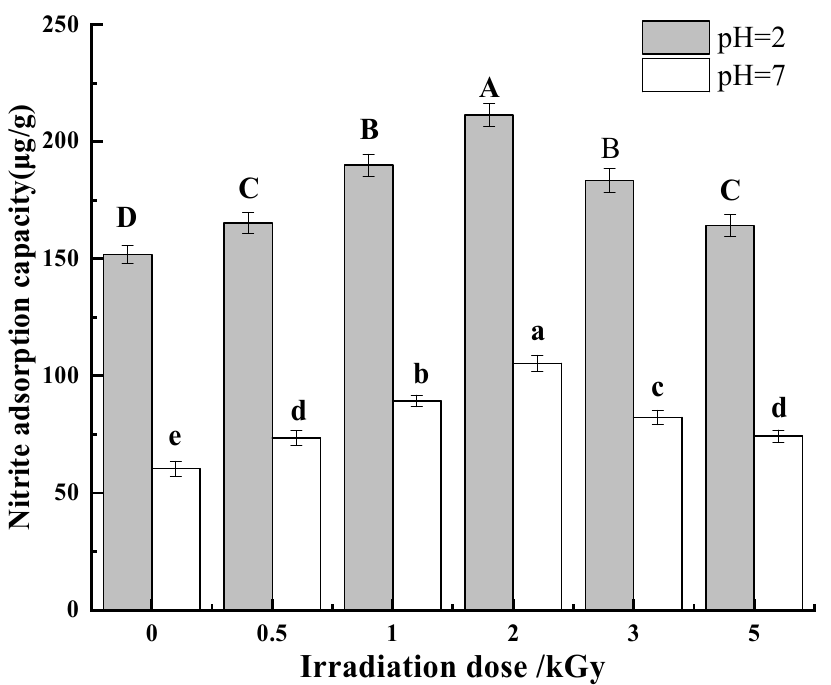
Figure 6. Effect of γ-irradiation on nitrite adsorption of pea fiber. Note: Different uppercase letters indicate significant difference in nitrite adsorption capacity under simulated gastric environment (pH = 2) ( p < 0.05), and different lowercase letters indicate significant difference in nitrite adsorption capacity under simulated intestinal environment (pH = 7) ( p < 0.05).